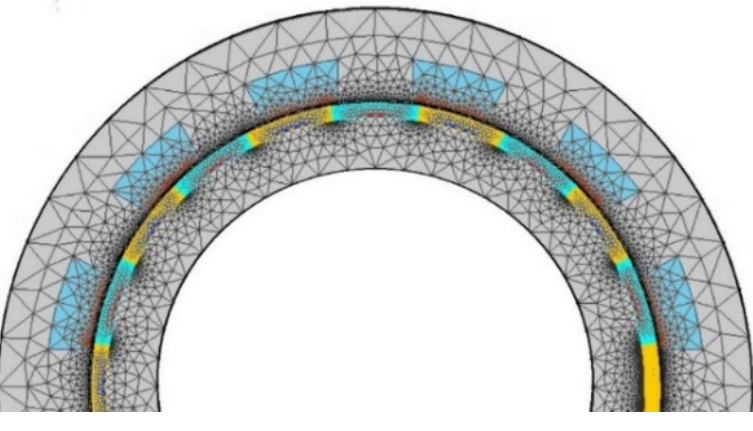
Figure 6. Mesh of a 1/2 model of the PMVM.